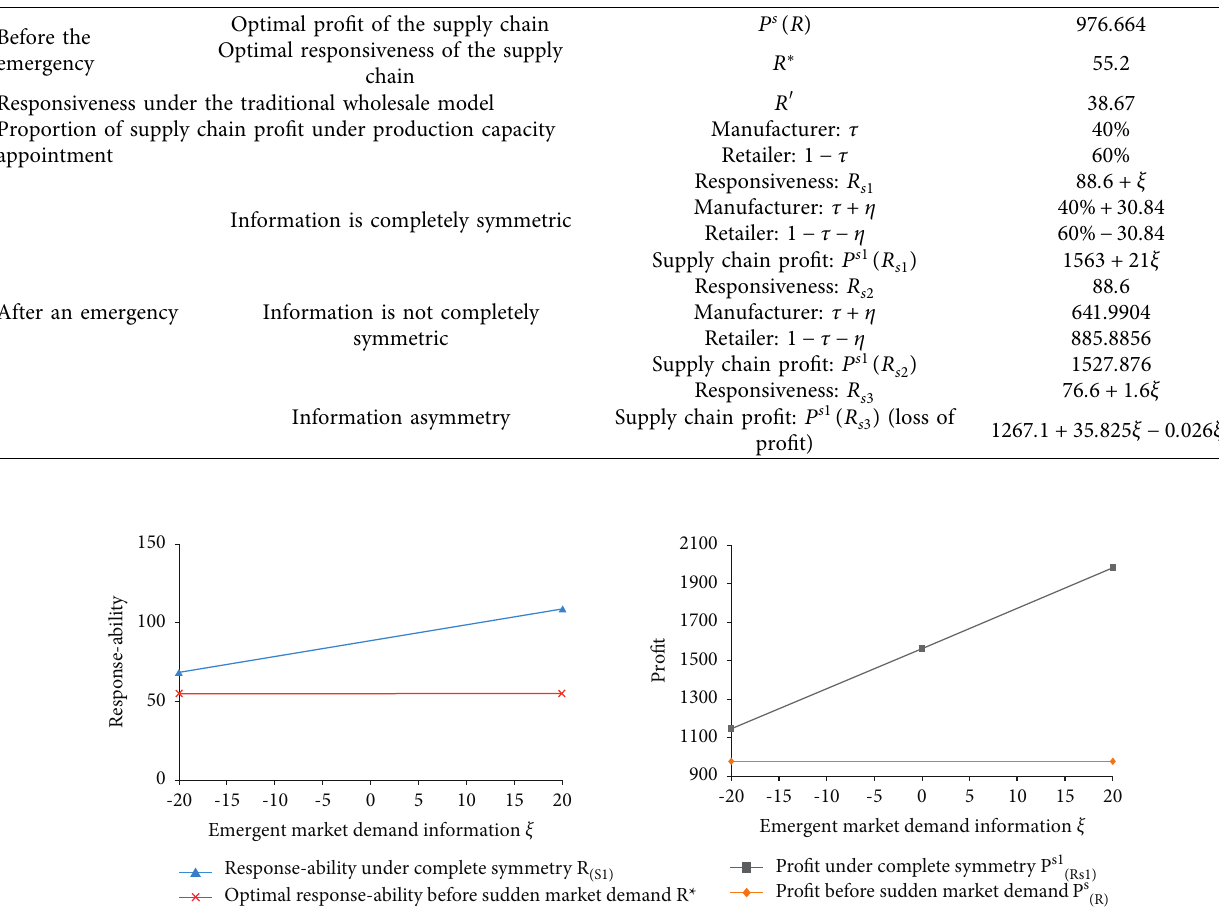
Figure 1: The change of supply chain’s profit and response ability under completely symmetrical information before and after an emergency.